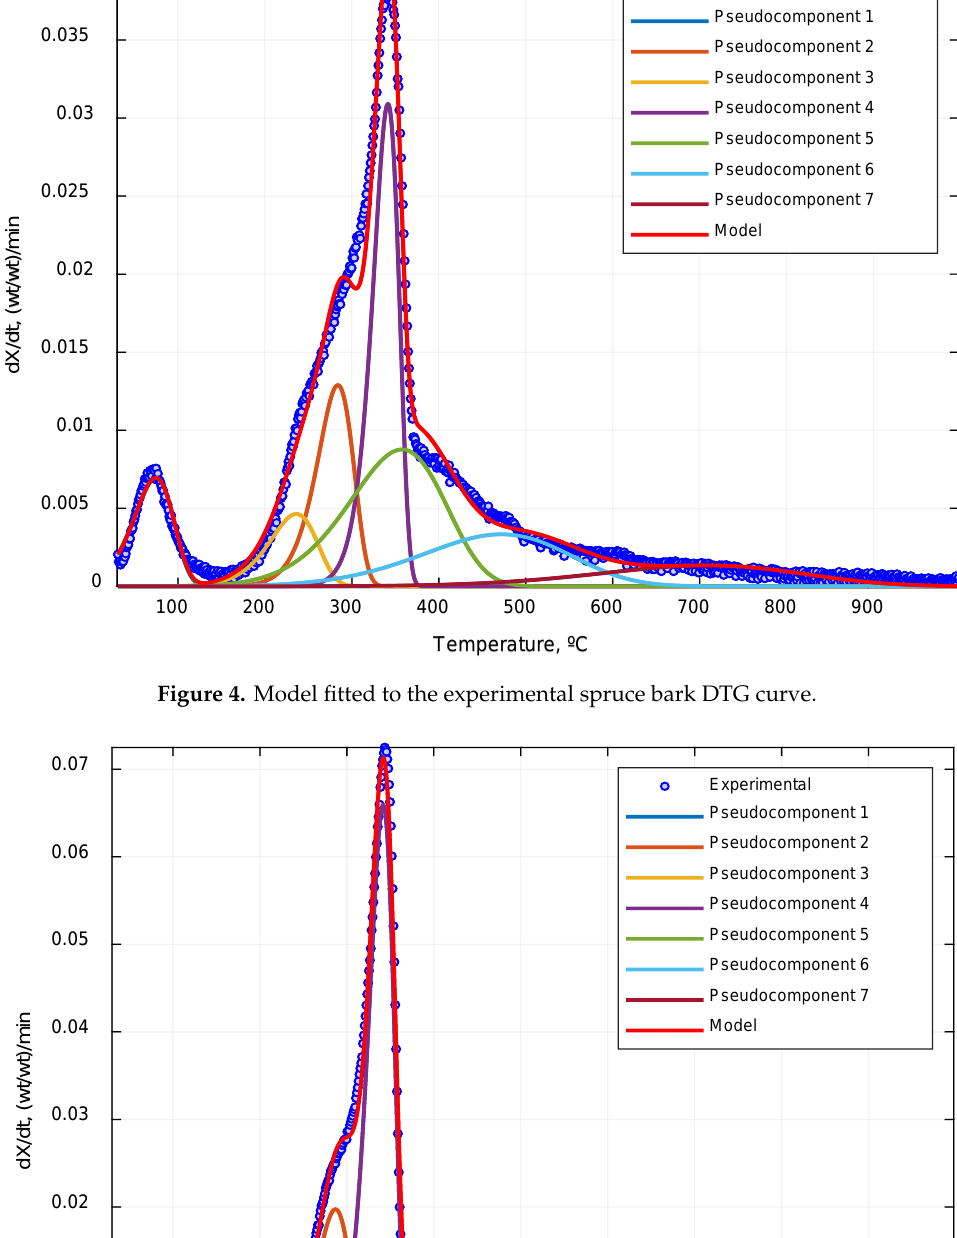
Figure 3. Model fitted to the experimental pine bark DTG curve.